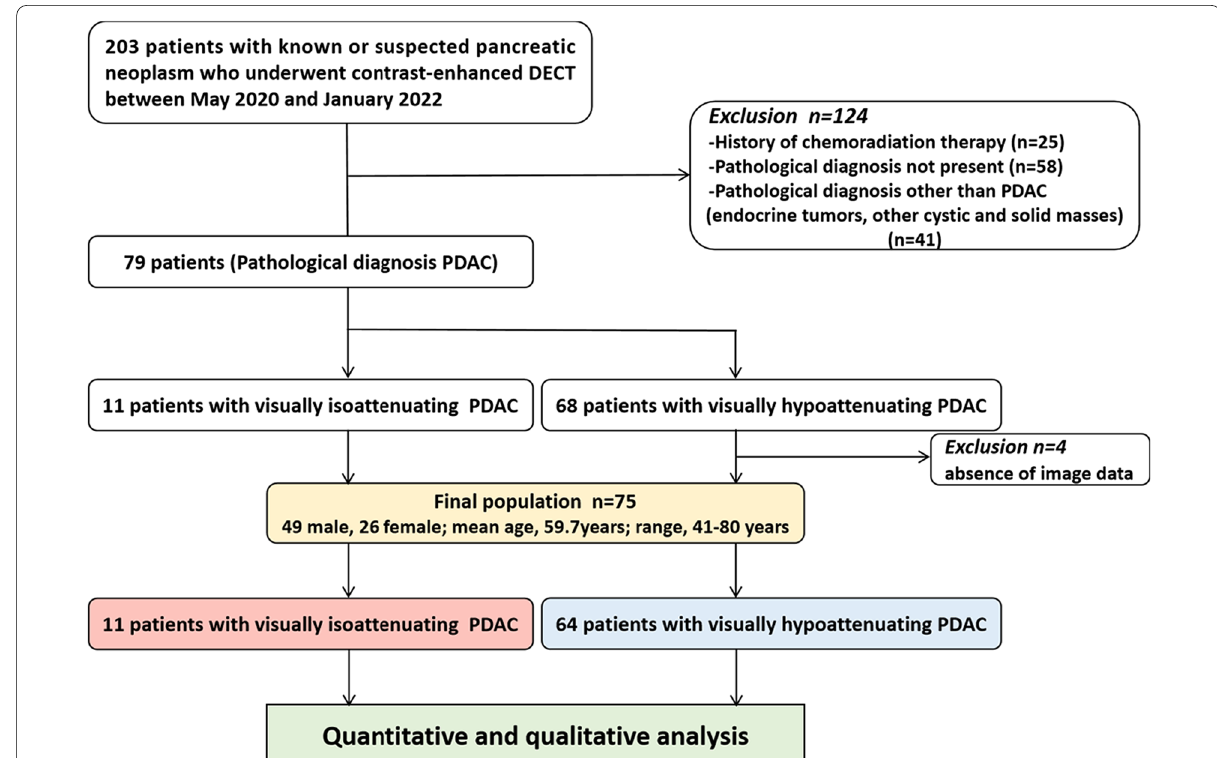
Fig. 1 Flow chart for the inclusion and exclusion of patients and imaging characterization of study